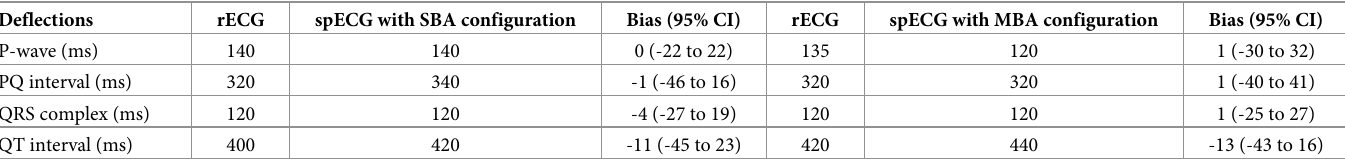
Table 1. Duration of cardiac deflections.